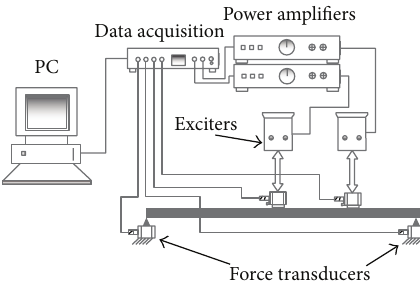
Figure 2: Illustration of the experimental setup developed for the study of force transmissibility.